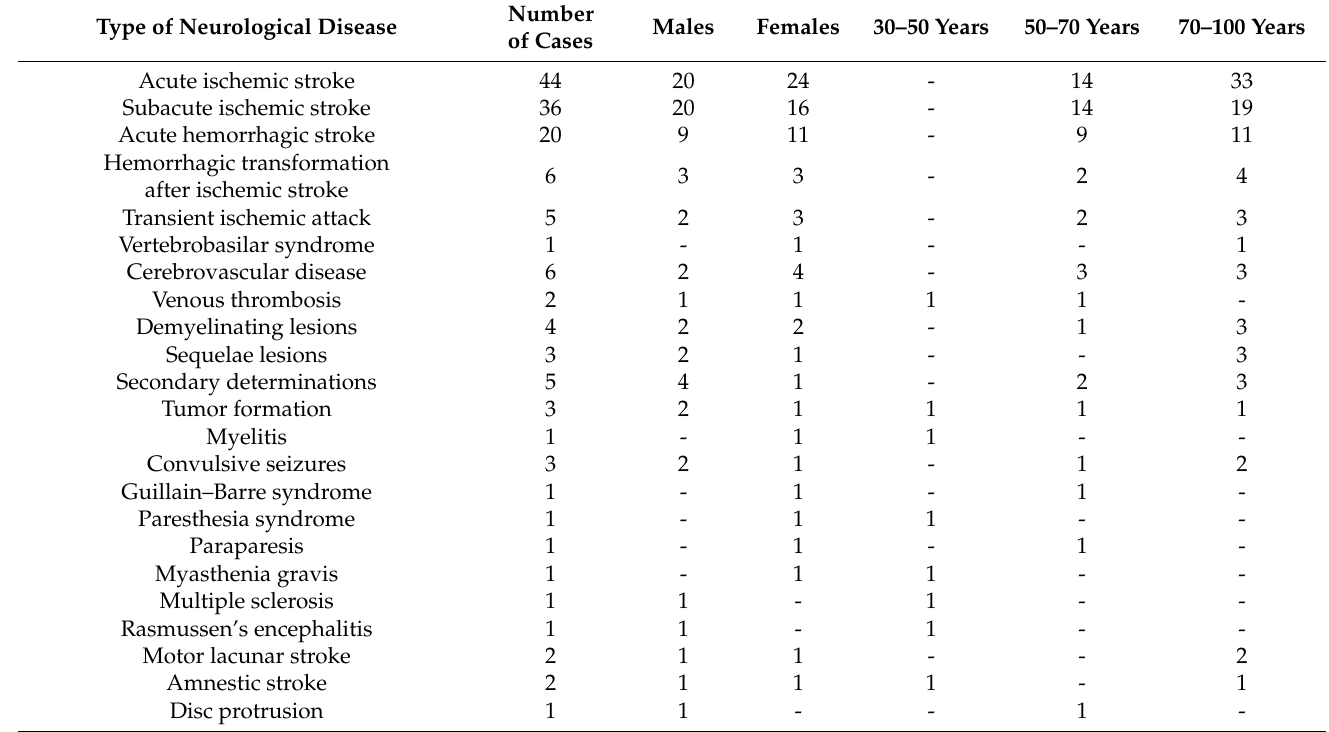
Table 1. Type of neurological disease presented by patients, number of cases, and patient